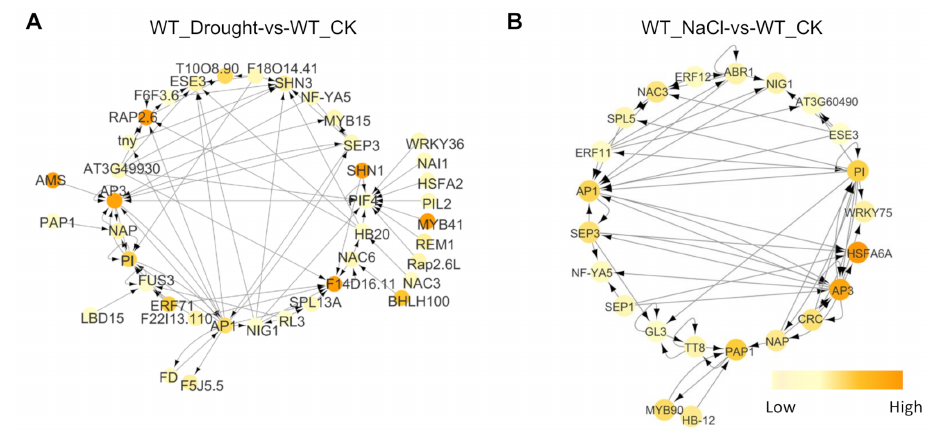
Figure 6. Analysis of transcription factor regulatory network of DEGs in WT under drought and salt stress. ( A , B ) The differentially expressed transcription factors in different comparison groups were screened and used to construct their direct mutual regulation network.